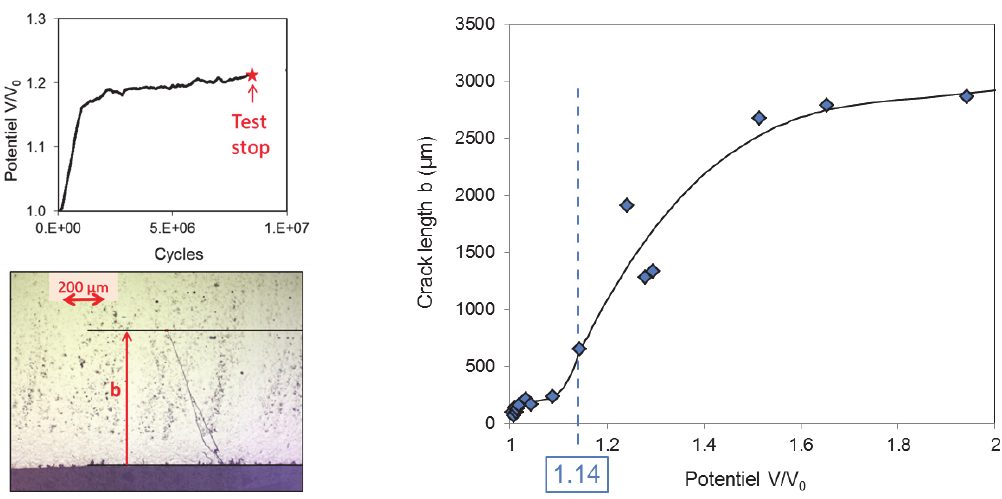
Figure 3: Identification of the calibration curve (R=4.6mm, P, σ F,moy / σ y,flat =0.78, R F =0.85, Q*/P=0.30). Fig. 3 plots the calibration curve. Its evolution is complex and was described by 2 successive polynomial